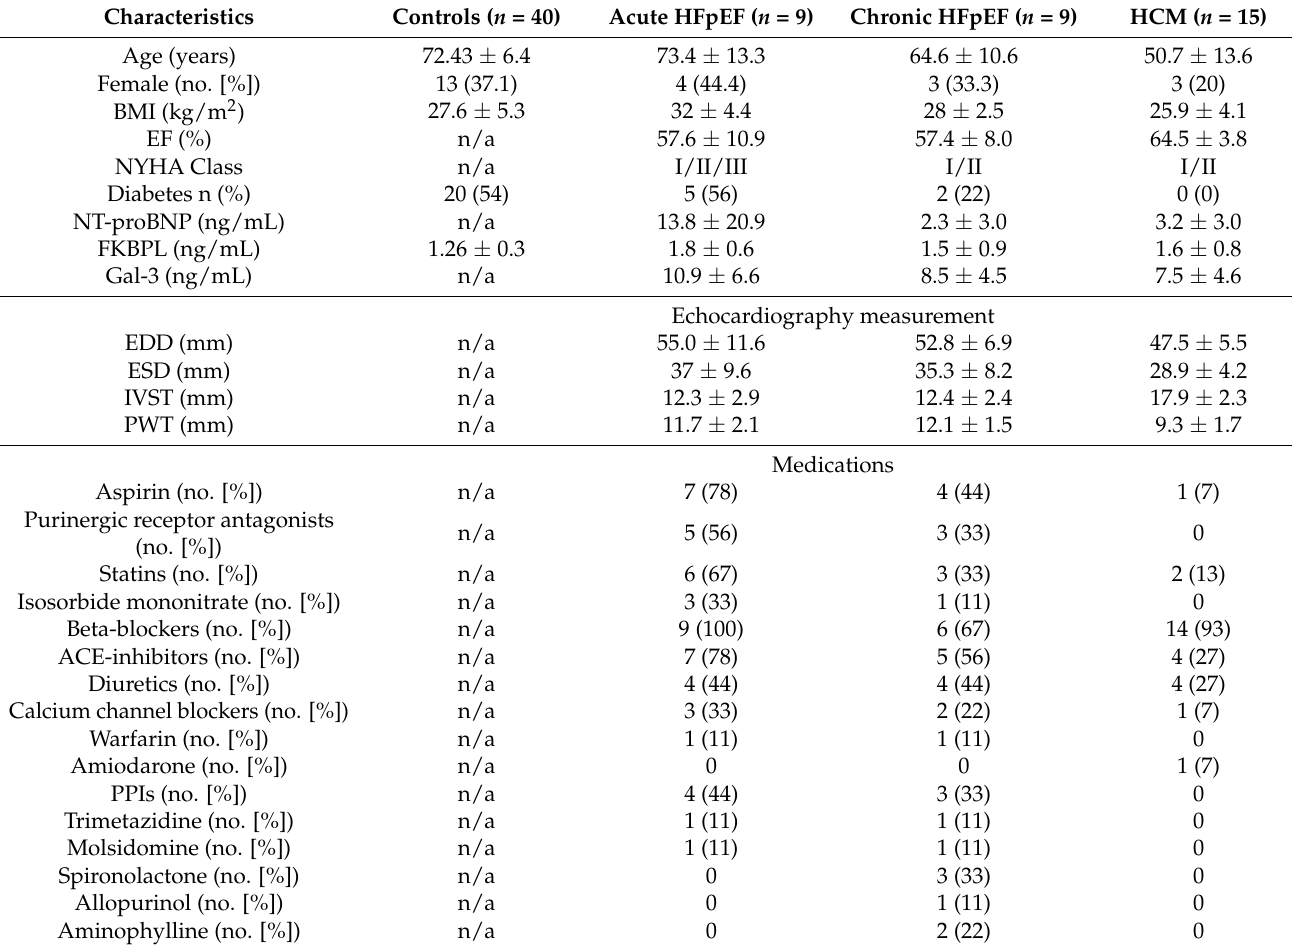
Table 1. Patient groups and clinical